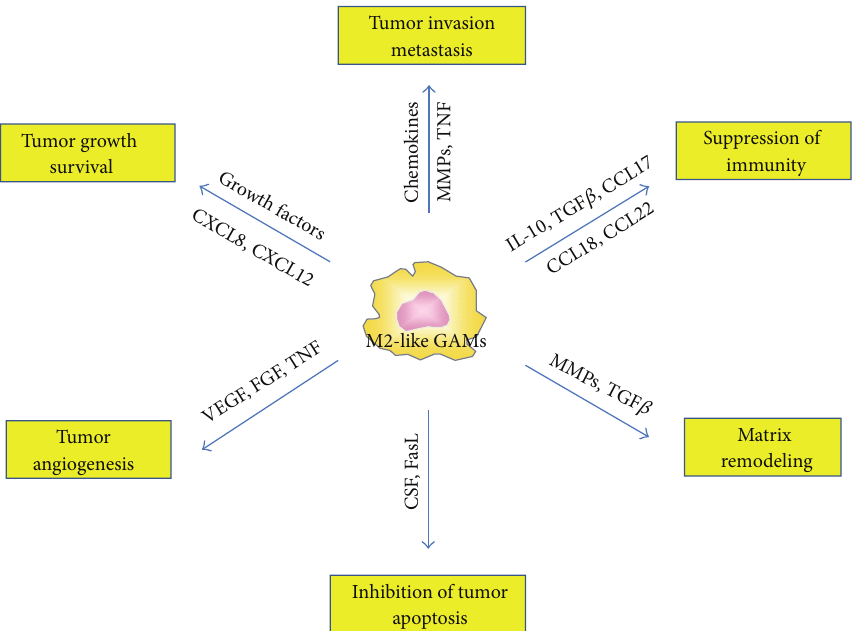
Figure 4: Glioma-associated microglia/macrophages (GAMs) are tumor supportive. Chemokines have a prominent role as they induce neoangiogenesis, activate matrix-metalloproteases (MMPs) and stroma remodeling, and direct tumor growth. Selected chemokines and immunosuppressive cytokines inhibit the anti-tumor immune